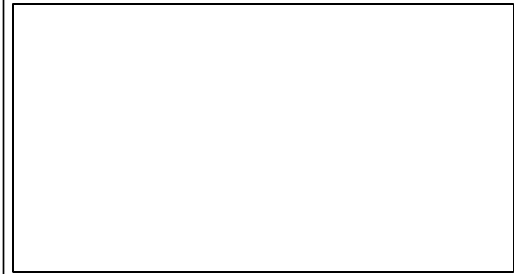
Table V : Poisoning cases that were